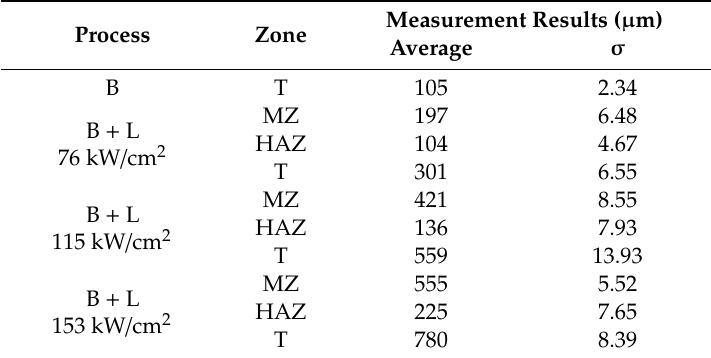
Table 3. Average thickness along with the standard deviation of the di ff usion boronized layer and the laser-modified boronized layers.